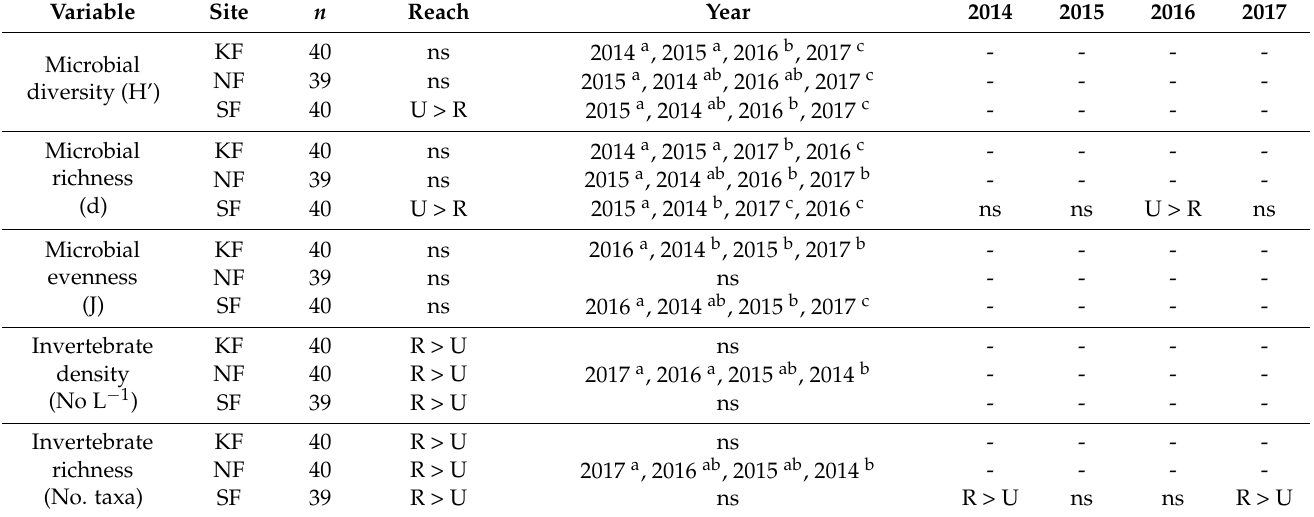
Table 1. Microbial and invertebrate diversity and density ANOVA results by reach, year, and interaction of reach and year. Significant differences by reach are designated as “>” or “<”; “ns” indicates p > 0.05; U = unrestored reach, and R = restored reach; KF = Kingfisher, NF = North Fork, and SF = South Fork. Differences by year are indicated with superscripted letters, and increasing values are arranged from left to right. Years with shared letters are not significantly different ( p > 0.05). “-” indicates there was no interaction effect of reach and year. Microbial metrics are based on OTUs in the planktonic fraction of hyporheic samples. Invertebrate density was log transformed and taxa richness square root